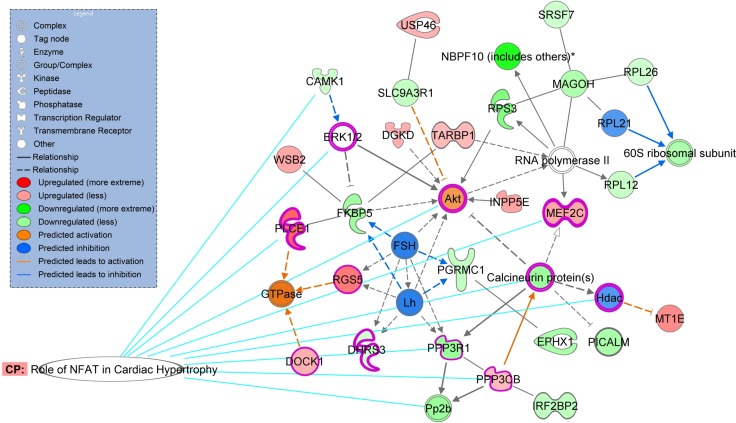
The network with highest score (P-score = 50, i.e. P-value < 10−50) was derived from 244 differentially expressed genes using Ingenuity Pathway Analysis Global Molecular Network algorithm.The edge in this network represents a relationship between two genes based on Ingenuity Pathways Knowledge Base. The genes with violet border color represent its functions related to cardiovascular system development, such as MEF2C, PLCE1, PPP3CB, and PPP3R1.